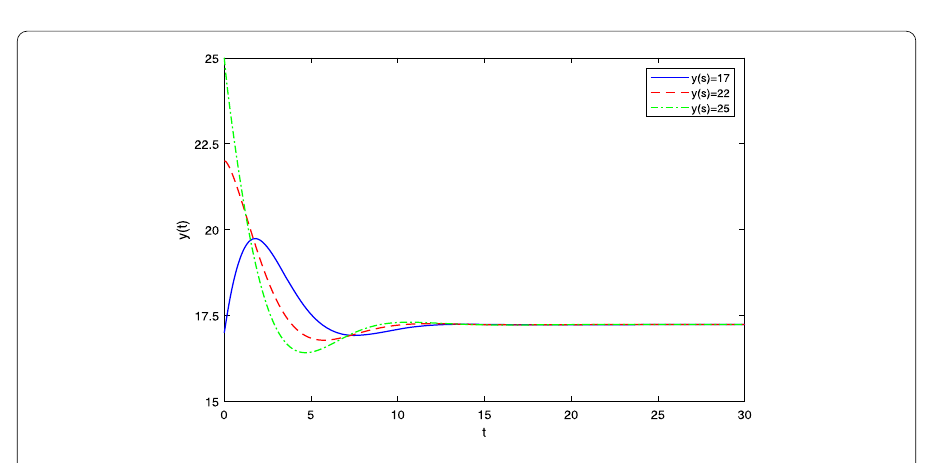
Figure 3 Time responses of state variable y ( t ) with α =